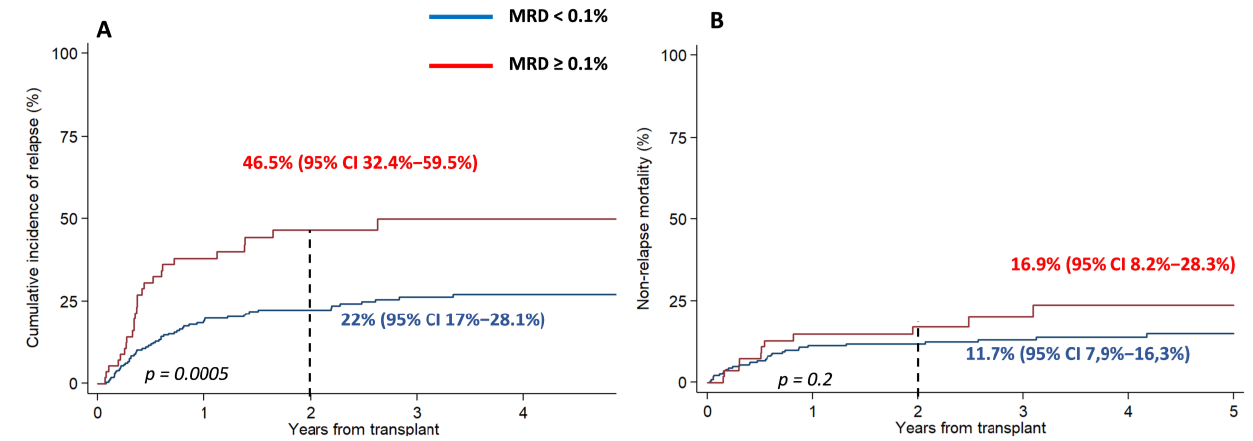
Figure 2. Impact of MRD in CIR and NRM: ( A ) CIR at 2 and 5 years were significantly lower among those with MRD ≥ 0.1. ( B ) However, no differences were observed in terms of non-relapse mortality.